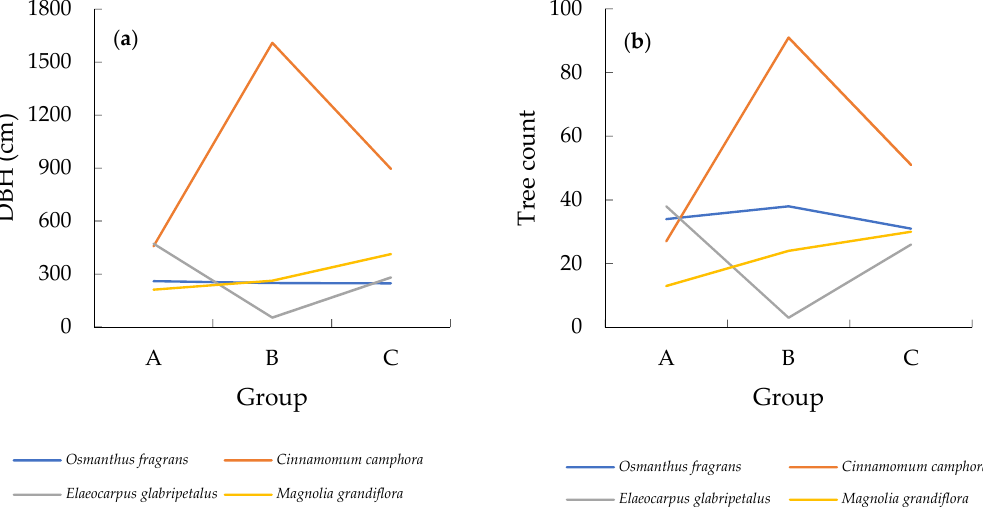
Figure 4. Distribution of four dominant trees species by ( a ) cumulative DBH and ( b ) tree count in three chronological groups of resettlement residential areas (RRAs) in Changzhou.